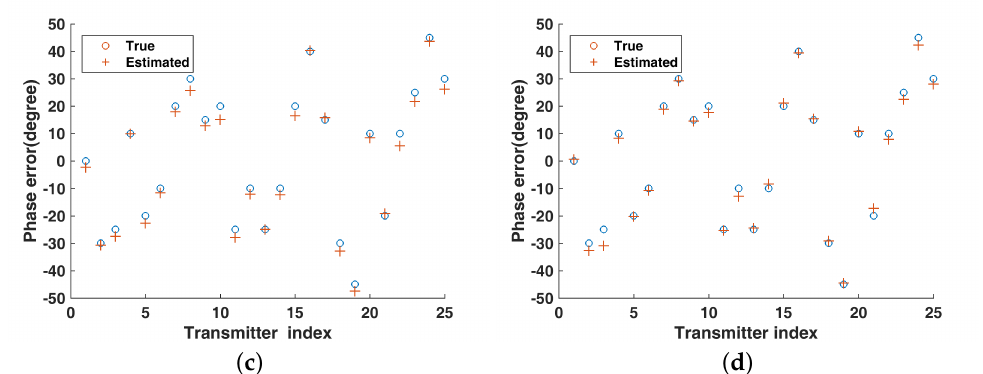
Figure 6. Phase error estimation under different number of strips ( a ) no strip; ( b ) two strips; ( c ) four strips; ( d ) eight strips.